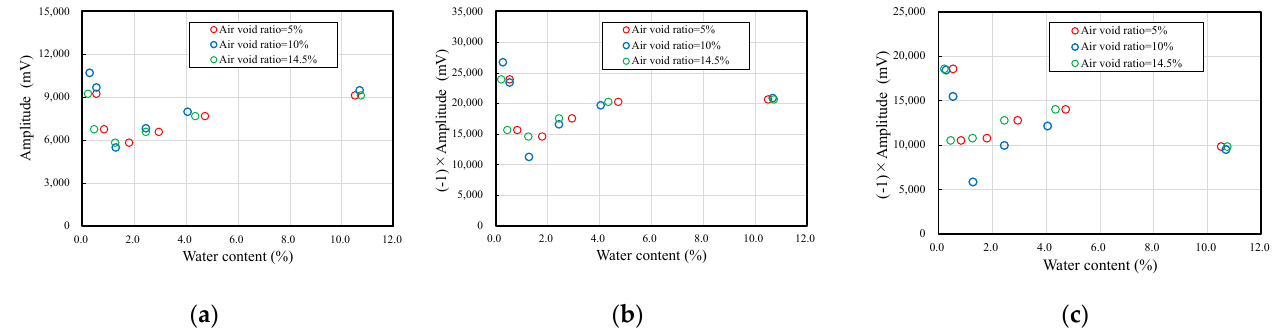
Figure 6. Comparison of the amplitude and water content: ( a ) first, ( b ) second, and ( c ) third wave.